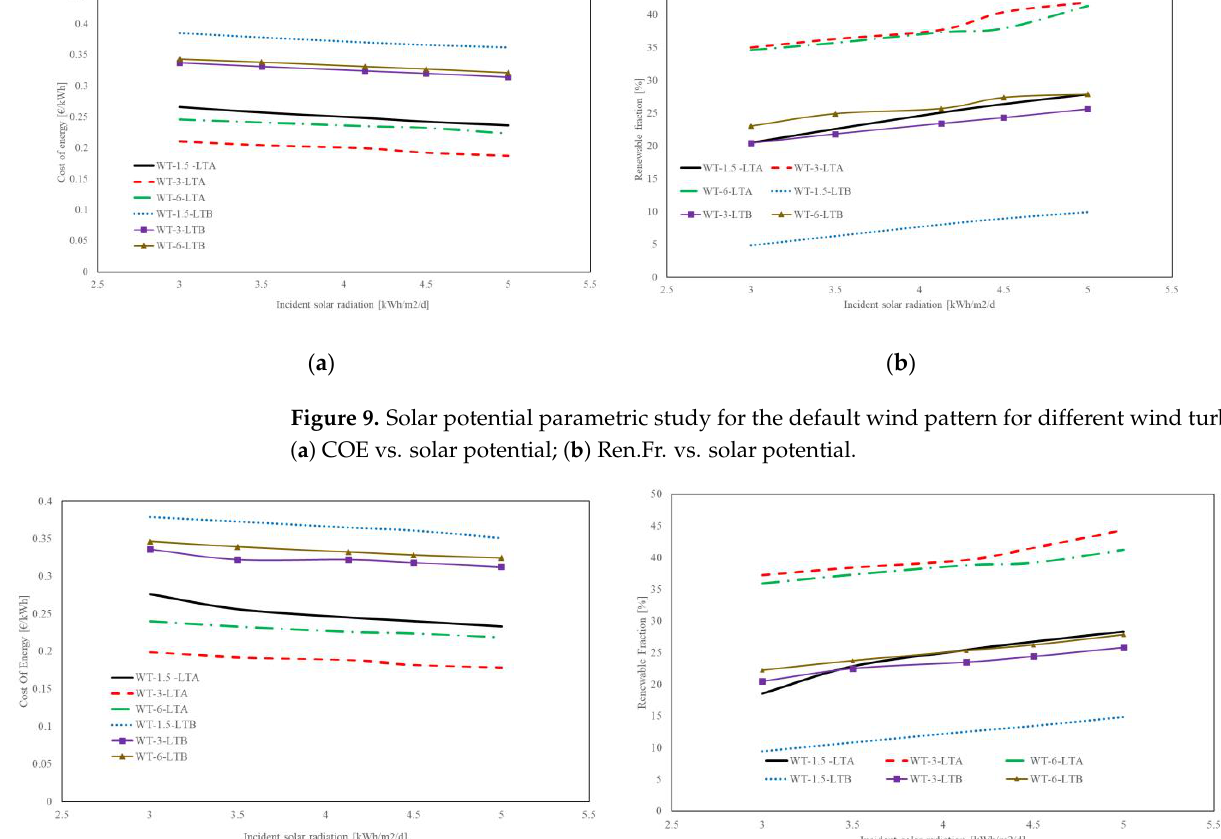
Figure 10. Solar potential parametric study for the wind pattern 2 for different wind turbines. ( a ) COE vs. solar potential; ( b ) Ren.Fr. vs. solar potential.